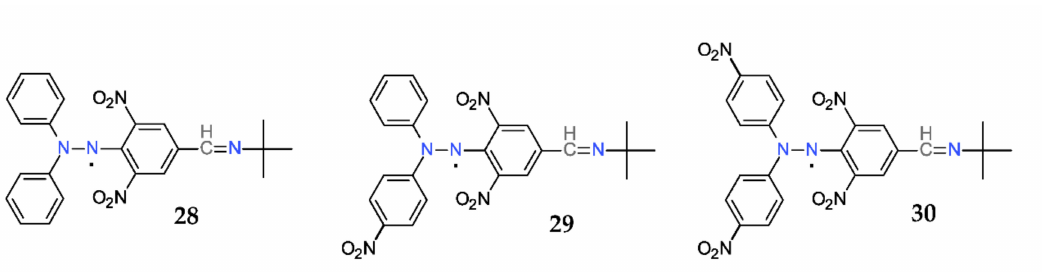
Figure 18. Hybrid